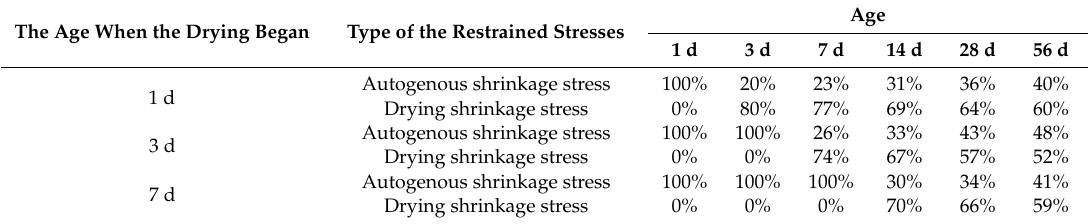
Figure 7. The development of the autogenous shrinkage stress and drying shrinkage stress under rebar restraint and different drying conditions. Table 4. The proportions of drying shrinkage stress and autogenous shrinkage stress in total restrained stress under rebar restraint and different drying conditions.